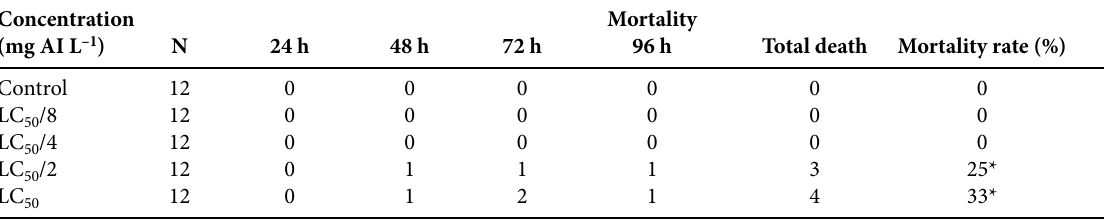
Table 2. The mortality of crayfish exposed to Thmx at different concentrations for 24, 48, 72 and 96-h. Concentration